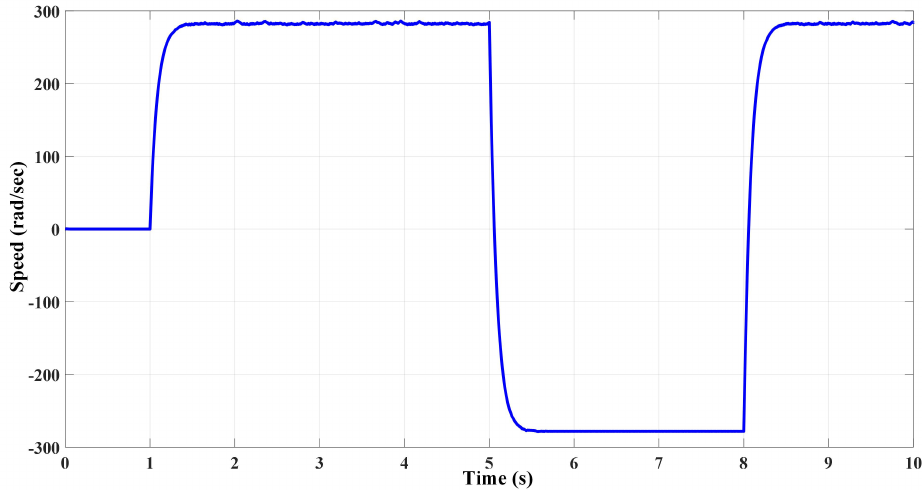
Figure 17. Speed response of the proposed strategy for nominal rotation.